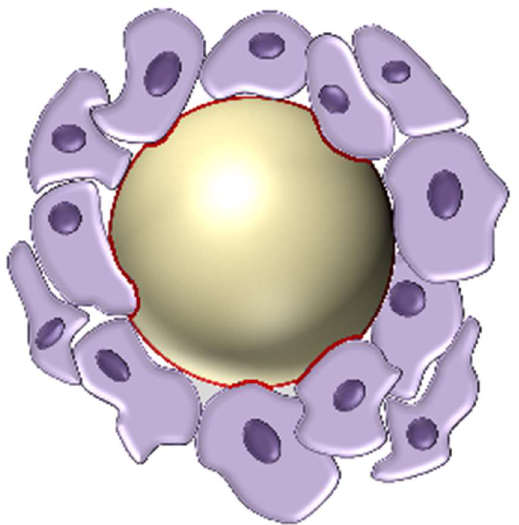
Figure 5. Schematic of oil micro droplet in vivo stress quantification described by Campàs et al. [203]. An oil droplet with calibrated surface tension is injected into living embryonic or cancerous tissue. As cells proliferate, they exert force onto the micro droplet and deform it. Deformations in curvature (red) of the oil droplet are used to calculate anisotropic stress within the tissue.